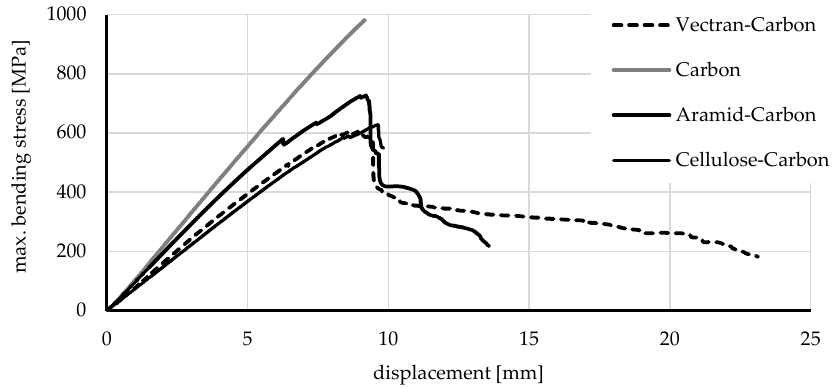
Figure 6. Fracture behavior under flexural loading.